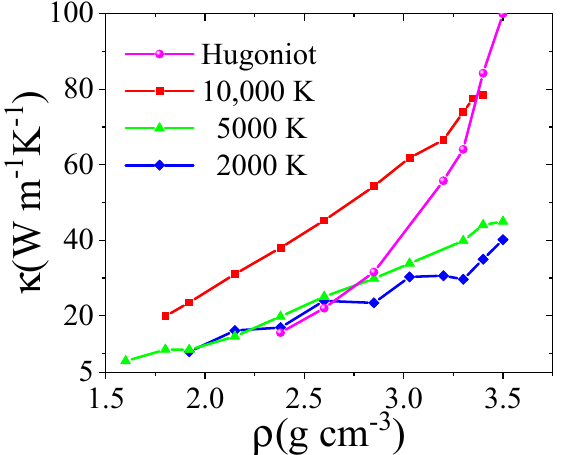
Figure 9. Thermal conductivity κ of warm dense NO along isotherms and the principal Hugoniot using PBE functional.